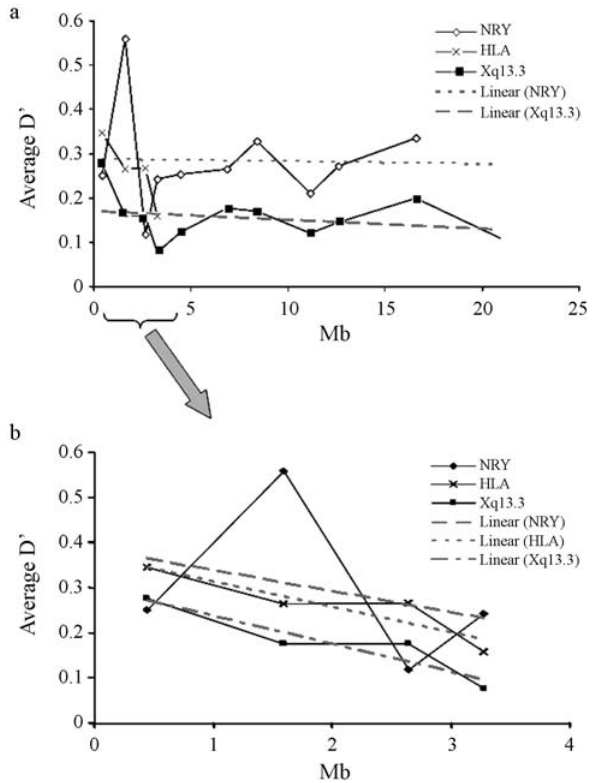
Figure 1 - Comparison of the LD extent in Xq13.3, NRY and HLA re- gions, evaluated as average multiallelic D’ values vs. physical distances fortheSãoMiguelIslandpopulation.Figure1bisanexpandedviewofthe 1-5Mbsectionof1a.ThereisadecreaseinLDvaluesforshorterdistances (< 4 Mb) in all